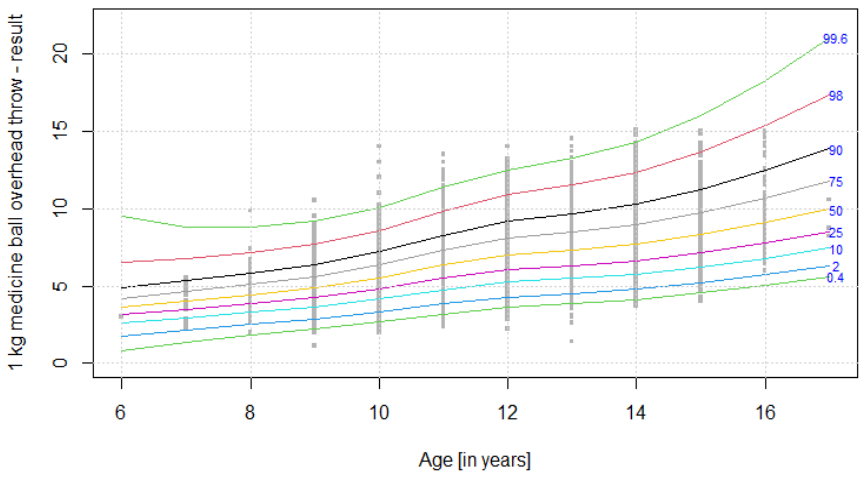
Figure 6. Centile chart for 1 kg medicine ball overhead throw in girls. Table 9. Values of particular centiles for 1 kg medicine ball overhead throw in girls.